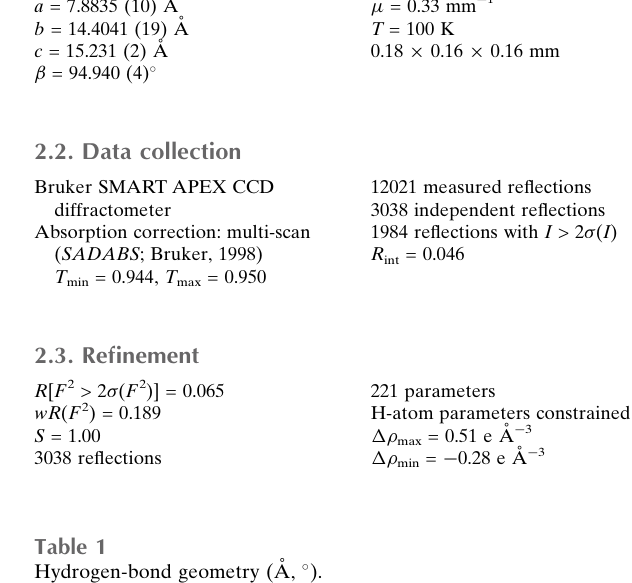
Hydrogen-bond geometry (A˚ , (cid:2)